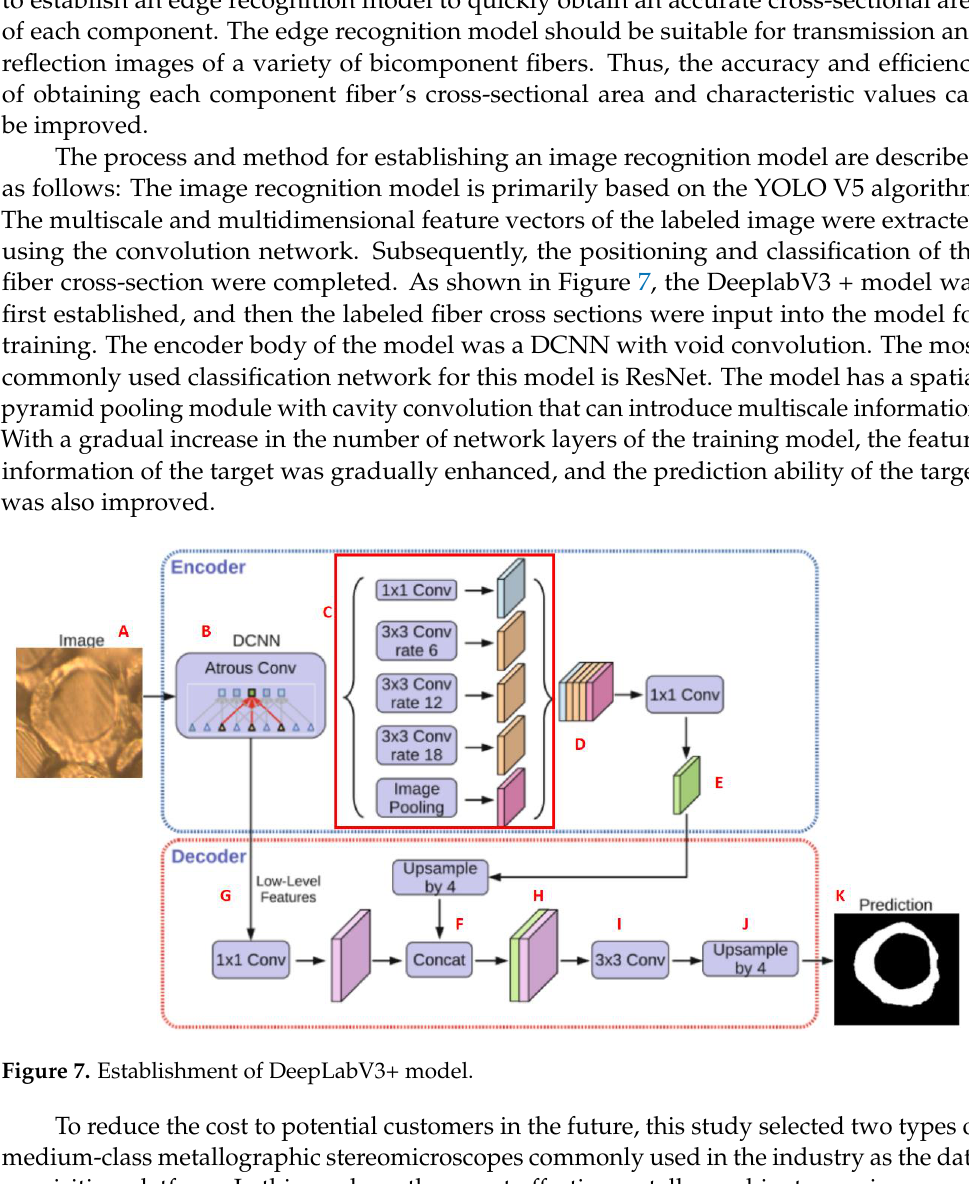
Table 2. Functional relationship between N and t (95% confidence level).